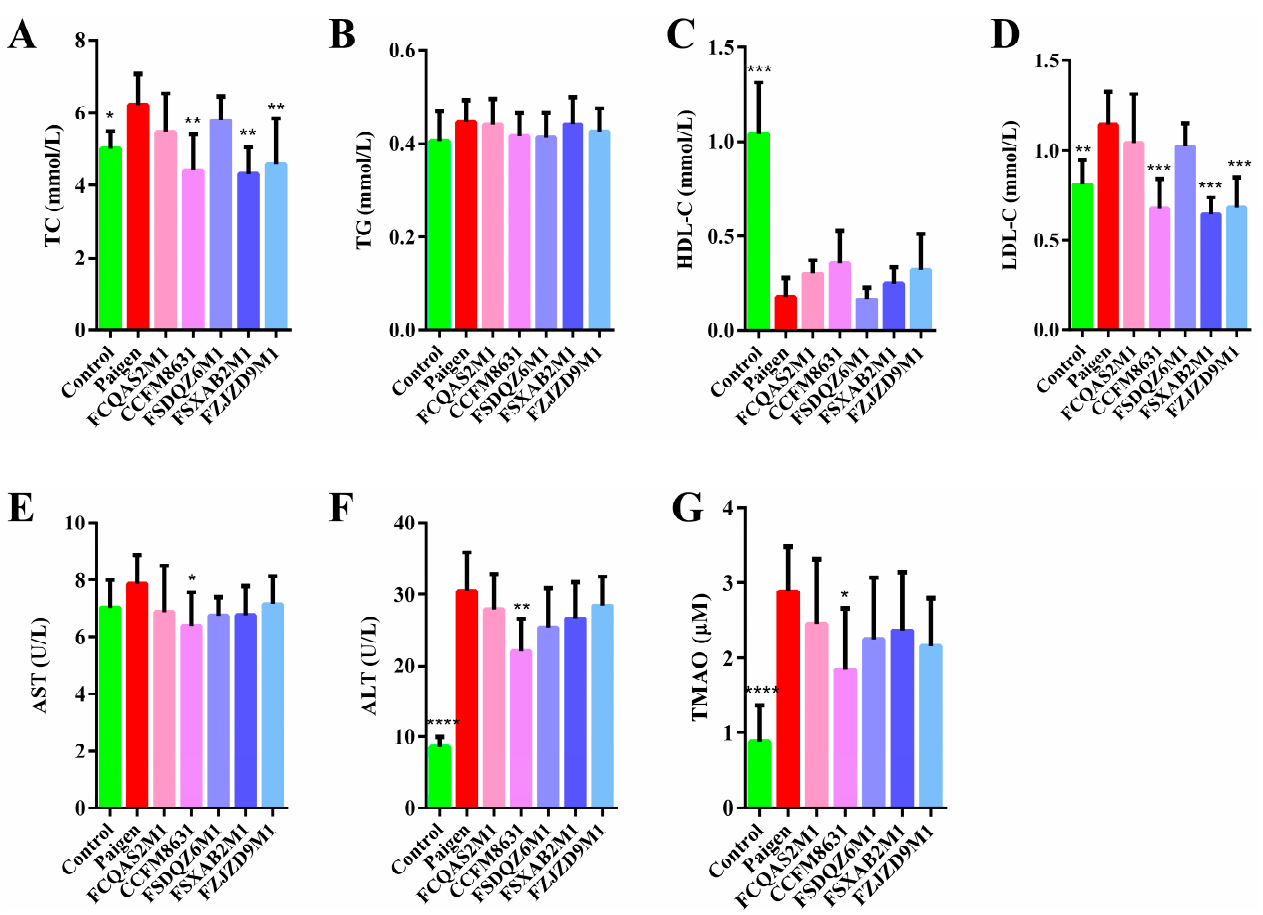
Figure 1. Analysis results of plasma biochemical parameters. ( A ) TC level. ( B ) TG level. ( C ) HDL-C level. ( D ) LDL-C level. ( E ) AST level. ( F ) ALT level. ( G ) TMAO level. n = 8. Compared with Paigen group, * p < 0.05, ** p < 0.01, *** p < 0.001, **** p < 0.0001.